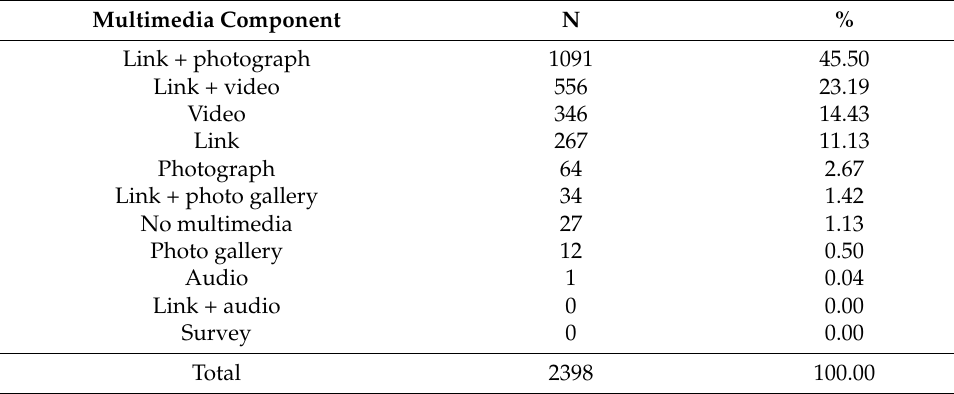
Table 7. Deployment of multimedia